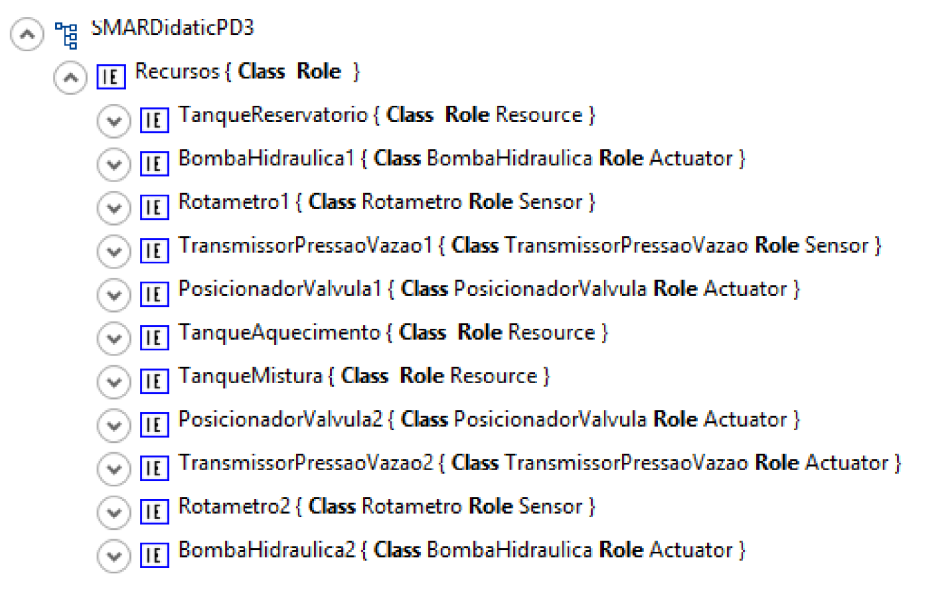
Figure 11. AML partial description.